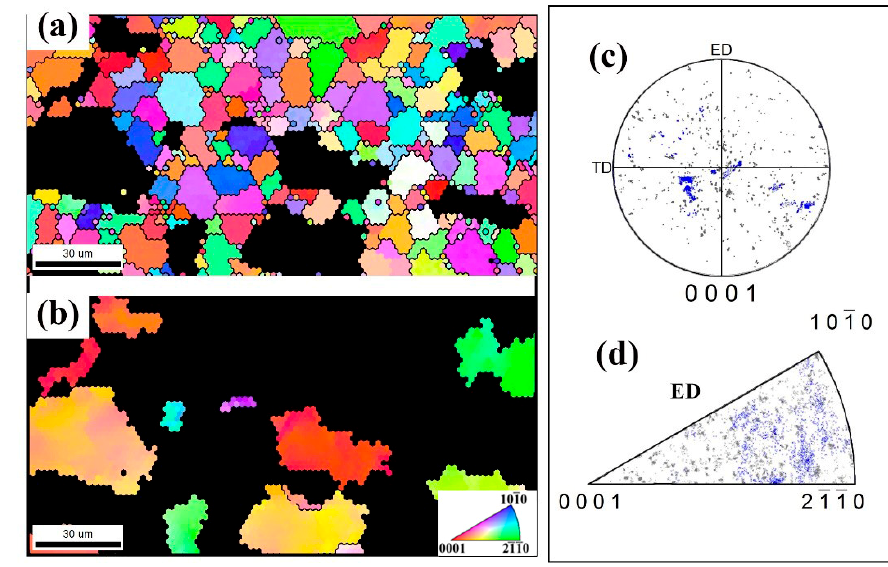
Figure 10. IPF coloring maps of DRXed ( a ) and unDRXed ( b ) grains after two-passes, and corresponding (0001) PF ( c ) and IPF ( d ).